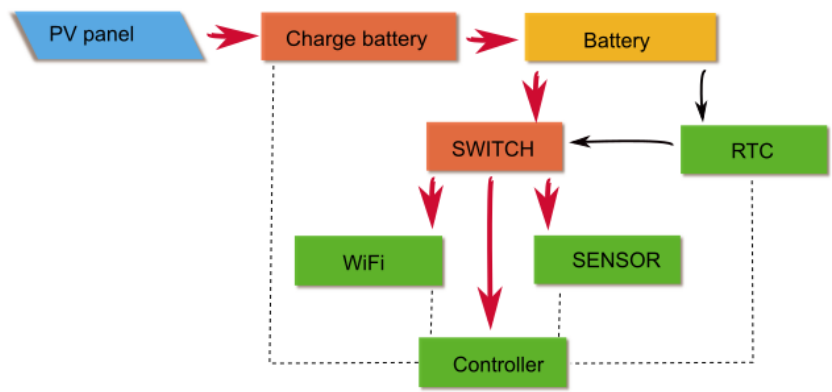
Figure 1. Block diagram of the device, where power lines are identified by red arrows, while dashed lines represent digital data and